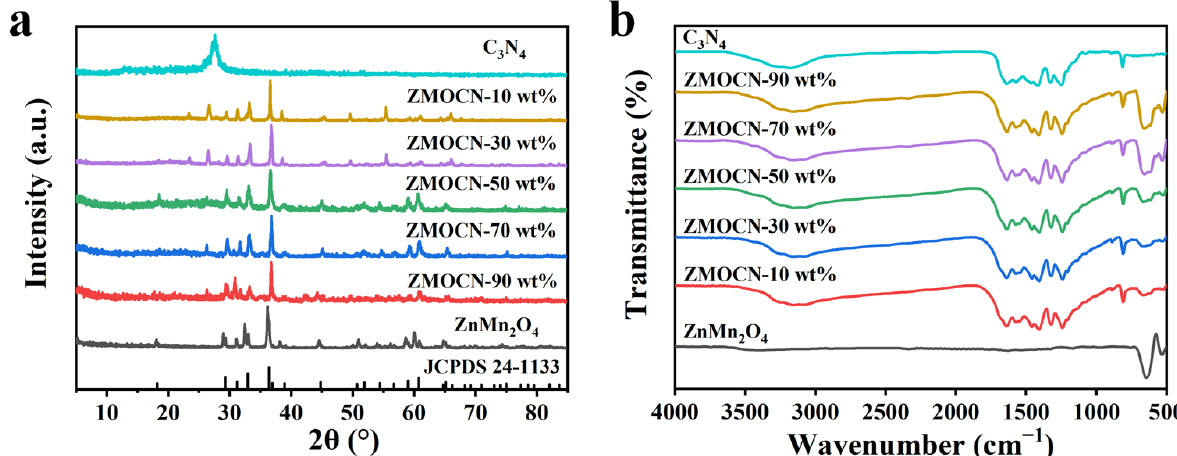
Figure 1. ( a ) XRD patterns of ZnMn 2 O 4 , C 3 N 4 , ZMOCN-10 wt%, ZMOCN-30 wt%, ZMOCN-50 wt%, ZMOCN-70 wt% and ZMOCN-90 wt%, respectively. ( b ) Infrared Spectroscopy (IR) of ZnMn 2 O 4 , C 3 N 4 , ZMOCN-10 wt%, ZMOCN-30 wt%, ZMOCN-50 wt%, ZMOCN-70 wt% and ZMOCN-90 wt%, respectively.